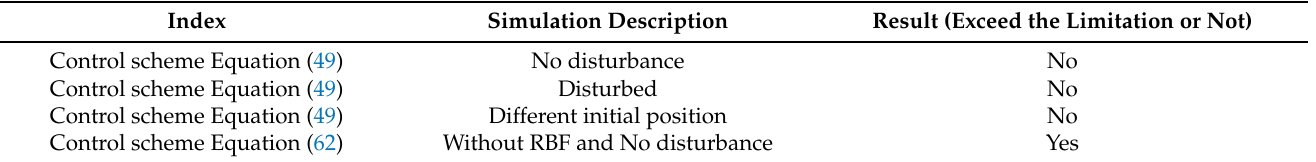
Table 1. Control scheme performance